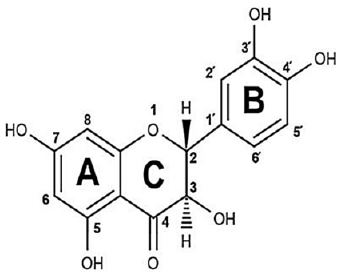
Figure 1. Chemical structure of taxifolin.